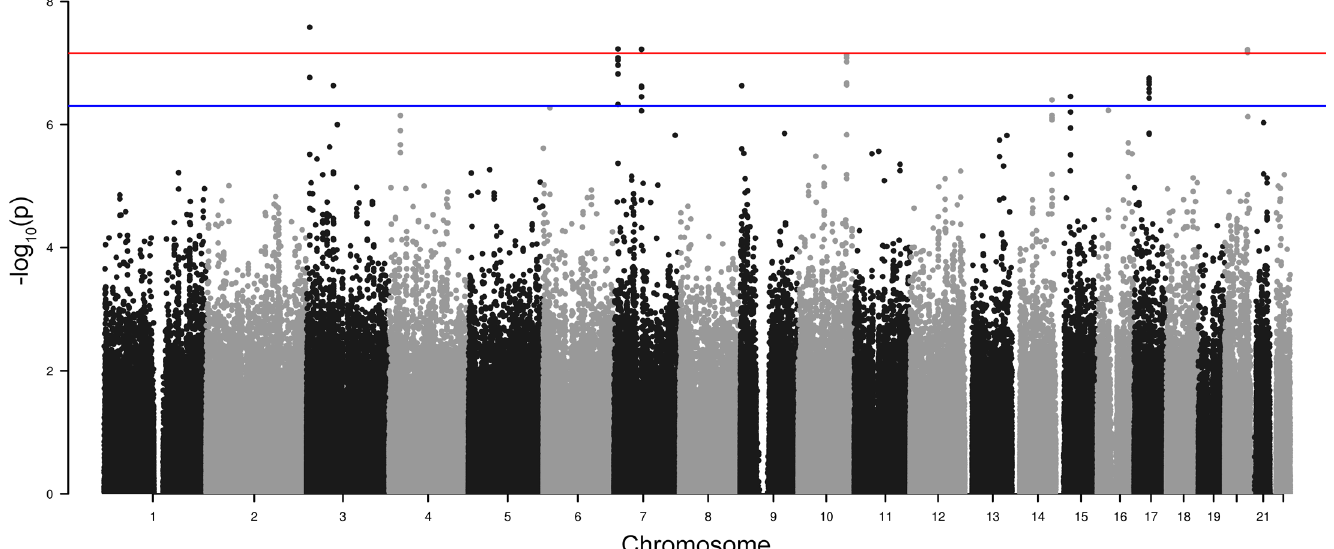
Fig 1. Manhattan plot of interaction p-values derived from the MESA genome-wide interaction analysis. Linear regression models, including main effects for SNP and asthma, and an interaction term for SNP × asthma, were used. Models were also adjusted for age, sex, and the first principal component. The red (upper) line represents the genome-wide significant p-value (0.05/721,893 = 6.93×10 − 8 ). The blue (lower) line represents the genome-wide suggestive p-value of 5×10 − 7 .